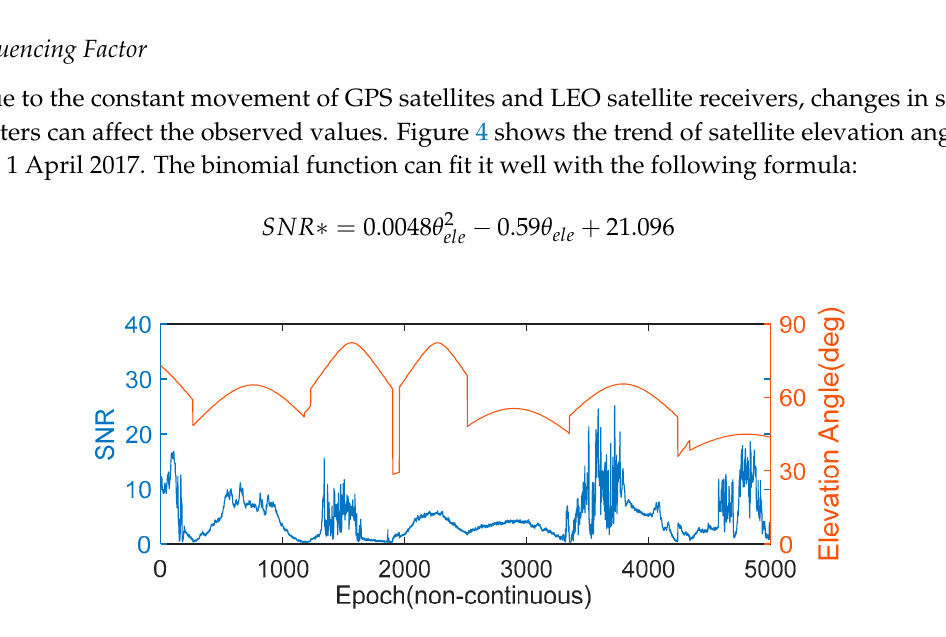
Figure 4. Trend of satellite elevation angle and SNR on April 1, 2017.